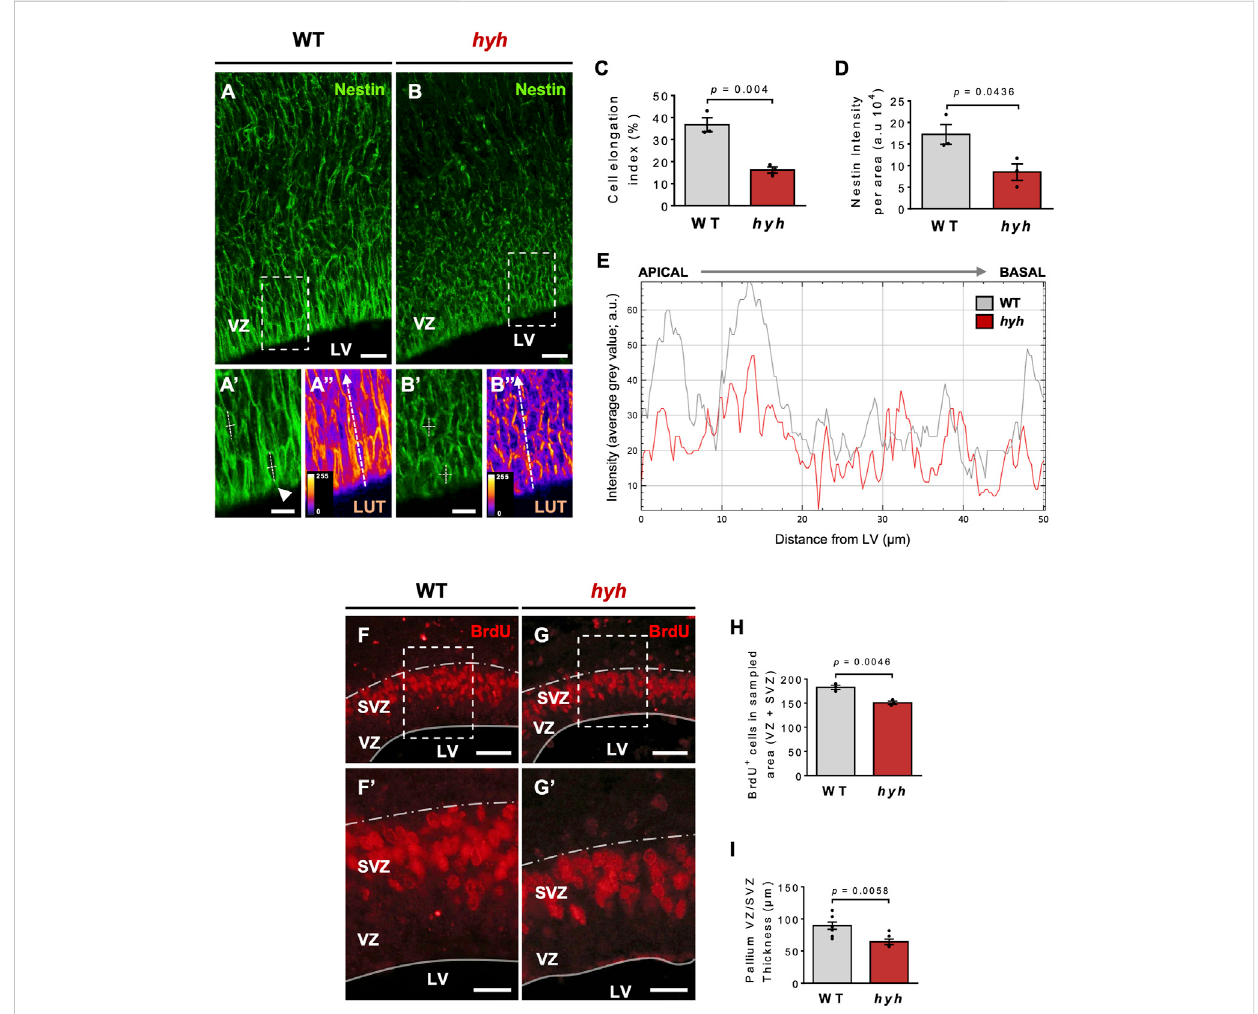
FIGURE 2 Consequences of hyh (M105I) mutation on apical NSPCs and ventricular zone (VZ) cytoarchitecture. ( A-B ’’ ) . Representative telencephalic coronal sections of WT and hyh mutant mice at E14.5 immunostained for Nestin, a marker of neural stem/progenitor cells (NSPCs). Dashed rectangles depict the zoomed area displayed in (A ’ -A ’’ ) and (B ’ -B ’’ ) (WT and hyh , respectively). (A ’’ ,B ’’ ) are the pseudocolored LUT (Look Up Table) versions of (A ’ ,B ’ ) , respectively, to highlight the intensity of theimmunoreaction and the shape of VZ cells. Apical-basal and lateral axes of the Soma of single NSPCs in theVZweremeasuredasdepictedin (A ’ ,B ’ ) (whitedashedlines)tocalculatecellelongationindex(seeC).Thewhitedashedarrowsfromapicaltobasalin (A ’’ ,B ’’ ) indicate the regions used for plotting the immuno fl uorescence intensity pro fi le shown in E. (C) . Cell elongation index (%) was calculated as EI=(AB – L)/(AB+L),where ABandLrepresenttheapical-basal(major)andlateral(minor)axesoftheellipse-shapedSomaofindividualNSPCs(seeA ’’ and B ’’ ). Five to 10 cells per picture (40X), four pictures per animal, and three animals per condition (WT and hyh) were analyzed. (D) . Quanti fi cation of Nestin immuno fl uorescenceintensity.Oneregionofinterest(ROI)of14,000 μ m 2 (80 µmlengthfromventricularsurface,175 µmwidth)wasconsideredineach section (4 sections per animal, three animals per condition). (E) . Plot of Nestin immuno fl uorescence intensity pro fi le in the VZ (as depicted with dashed whitearrowsinA ’’ andB ’’ forWTandhyh,respectively).Adistanceof50 µmfromventricularsurface(apicaltobasal)wasmeasured.Notethereductionof Nestin immuno fl uorescence intensity particularly in the most apical region. (F,G) . Representative coronal sections of WT (F) and hyh mutants (G) at E14.5immunostained forBrdU. Dashedrectangles indicate theareasdisplayed withhigher magni fi cationinF ’ andG ’ . (F ’ ,G ’ ) . Highermagni fi cationsofthe VZ/SVZ at the level of the dashed rectangles in F and G. The thickness of the VZ/SVZ is depicted. (H) . Quanti fi cation of BrdU positive cells of VZ/SVZ normalized by sampled area in WT (n = 3) and hyh (n = 3) mice. (I) . Morphometric analysis of VZ/SVZ thickness in WT (n = 8) and hyh (n = 6) mice. Data is shown as mean +/- S.E.M. Differences with p < 0.05 were considered signi fi cant (Student ’ s t-test with Welch ’ s correction). LV, Lateral Ventricles, VZ, Ventricular Zone, SVZ Subventricular zone. Scale Bars: A-B = 20 µm; A ’ -B ’ = 10 µm; E-F = 50 µm; E ’ -F ’ = 20